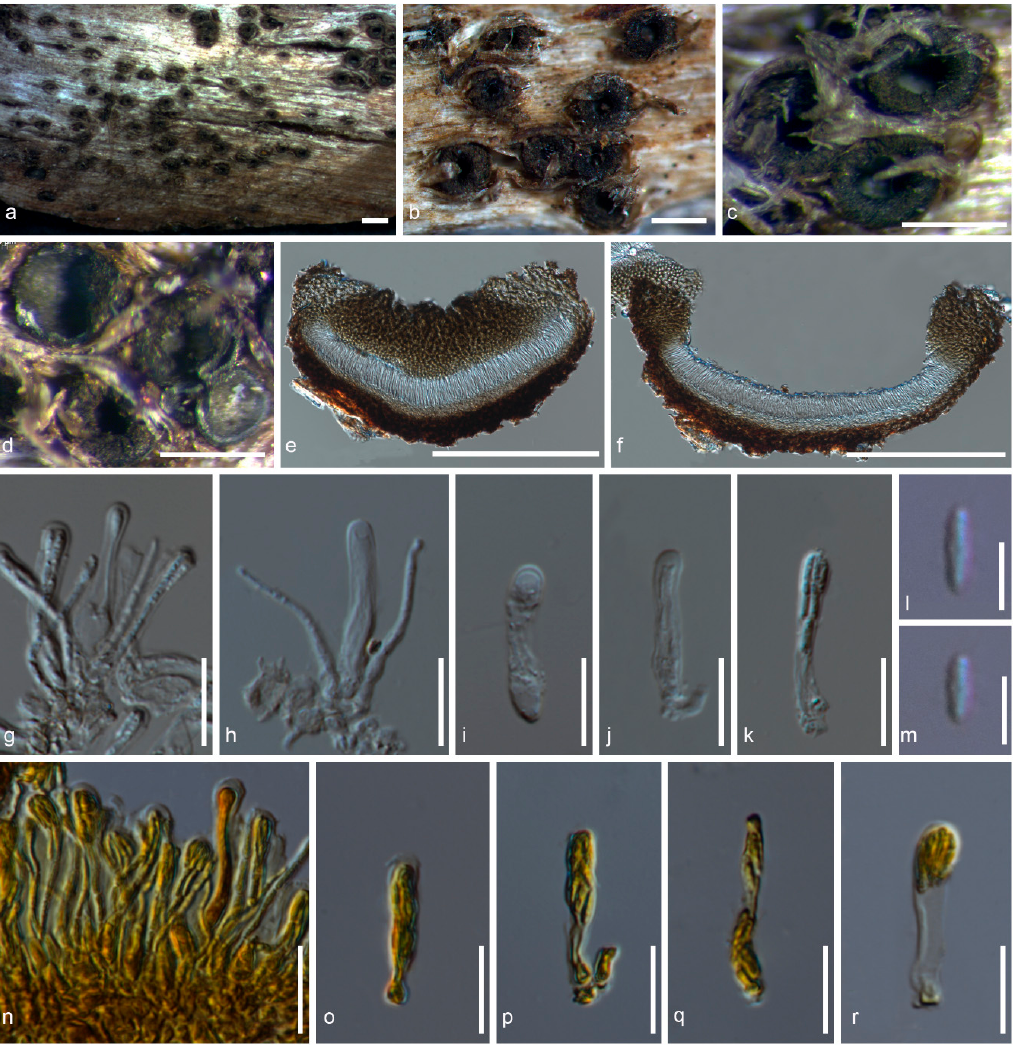
Figure 6. Sphaeropezia shangrilaensis (MFLU 20-0537). ( a – d ) Ascomata on substrate. ( e , f ) Vertical section through an ascoma (in water). ( g ) Paraphyses (in water). ( h – k ) Asci (in water). ( l , m ) Ascospores (in water). ( n – r ) Asci (in KI). Scale bars a = 1000 µm, b – d = 500 µm, e, f = 200 µm, g – k, n – r = 10 µm, l, m = 5 µm.